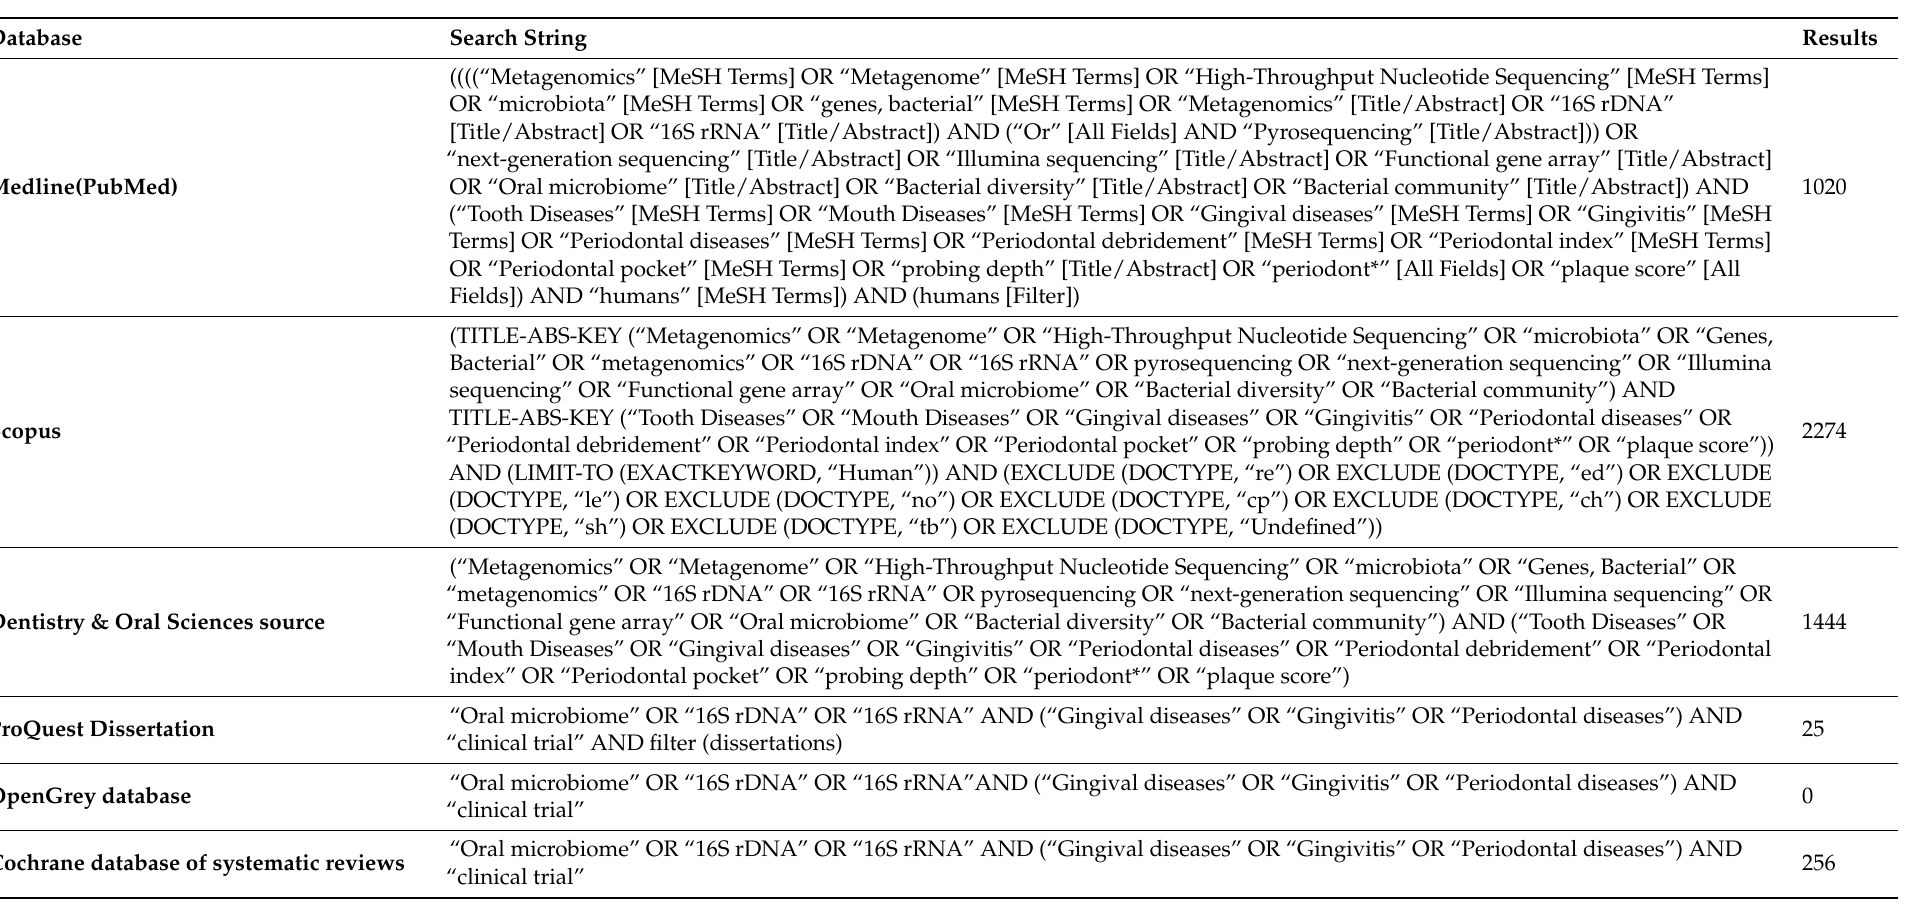
Table A1. Search